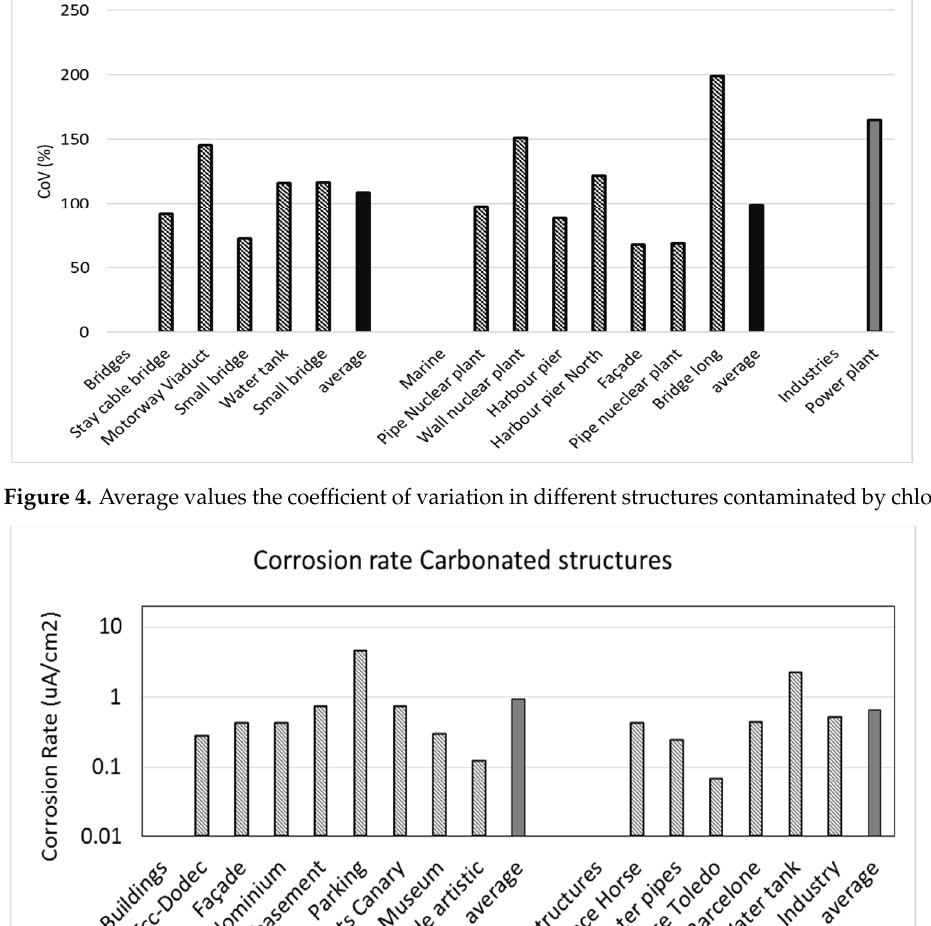
Figure 6. Average values of the coefficient of variation in different carbonated structures. In the figures, it can be appreciated that the values of corrosion rates above 1 µA/cm 2 are not frequent, as the most frequent values are between 0.1 and 1 µA/cm 2 . Regarding the CoV, values above 100% indicate the existence of both, passive and corrosive zones in the structure, while values smaller than 100% are calculated for areas where all the zones are actively corroding. That is, the CoV indicates a spatial variation of the corrosion rate but depends on the zones selected for the measurements. 4. Discussion 4.1. Chloride Threshold 4.1.1. Statistical Characterization From the values in [15], a first statistical analysis was made whose generic represen- tation is given in Figure 2. This generic representation is made for further comparison in the Discussion with other distributions found by other authors. In Figure 7, two generic distributions are shown, because in [15], two main populations of data were identified: one for values of potential more anodic than −200 mV SCE and the other more cathodic val- ues. Above (more anodic) or below (more cathodic) this potential, the distribution changes its average value. The joint consideration of both distributions explains the large